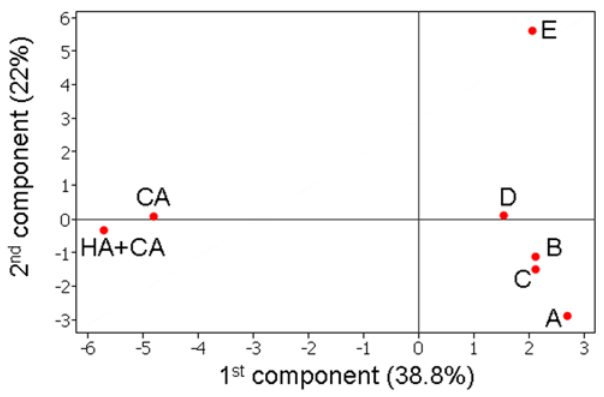
Figure 4. Principal components analysis. The datasets from the five kindergartens (A–E), the total disease dataset (CA + HA) and just the community-acquired dataset (CA) were plotted according to the two largest components. These accounted for 38.8% and 22% of the variation in the data respectively. The first component separated the disease isolates from the carriage isolates, whilst the second component distinguished between the different kindergarten samples.